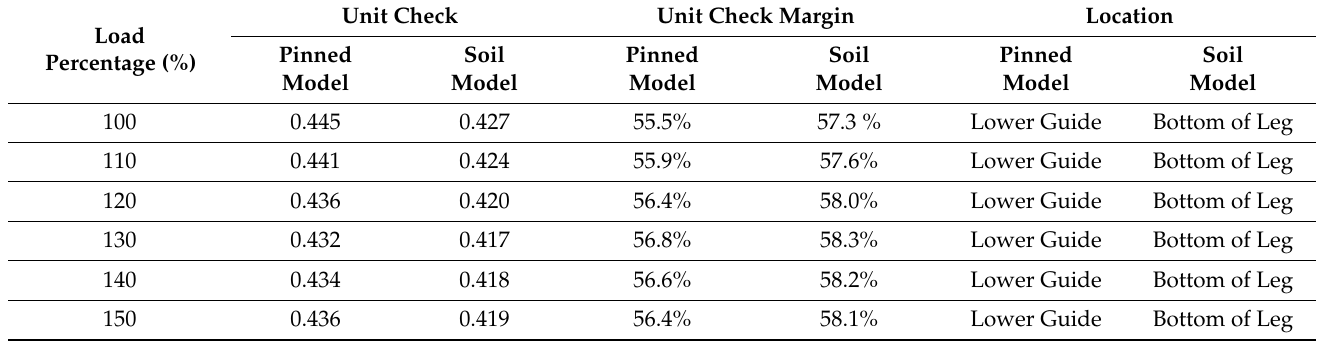
Table 6. Effect of structural response according to parameters for wave period.